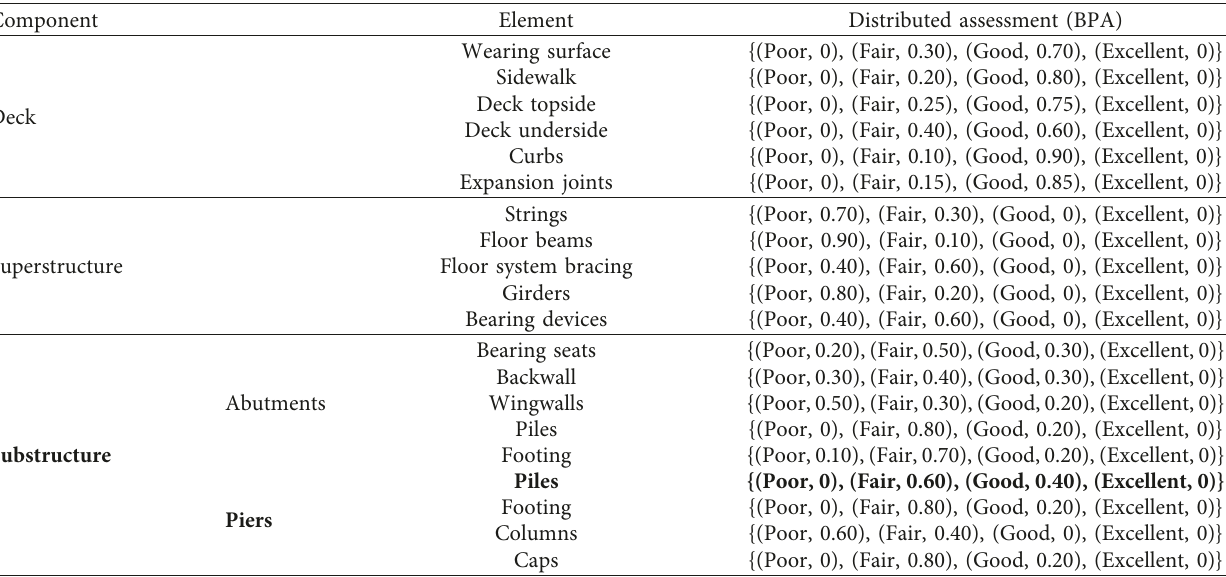
Figure 2: The MCS results for the bridge deck. Table 6: Bridge elements distributed